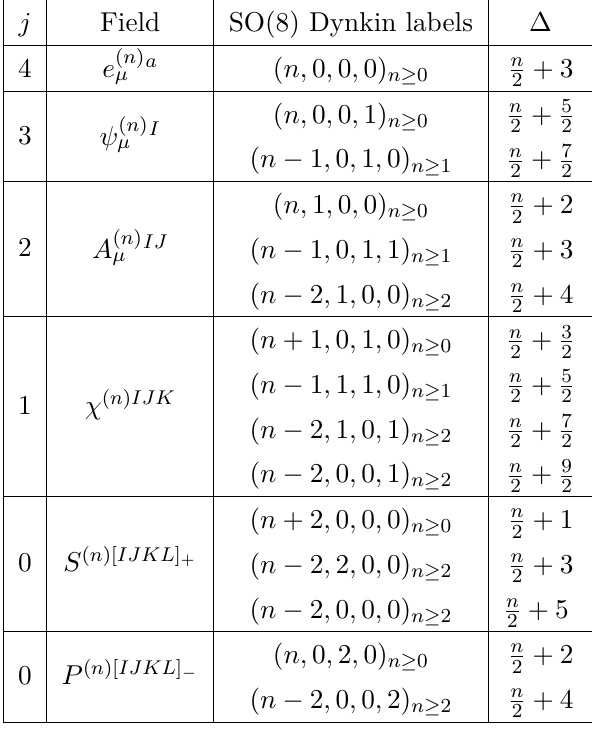
at KK level n . The notation is the n +1 2